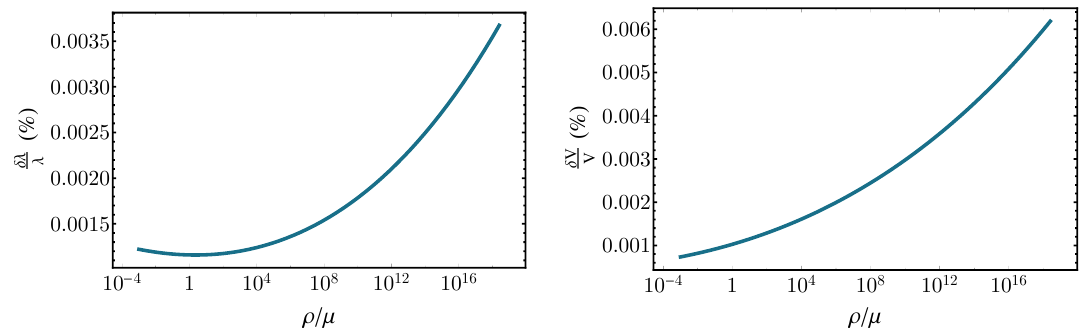
Figure 9 . The relative di(cid:11)erences between the one-loop and two-loop running coupling (5.7) (left panel) and improved potentials (5.8) (right panel) for N = 10 scalar